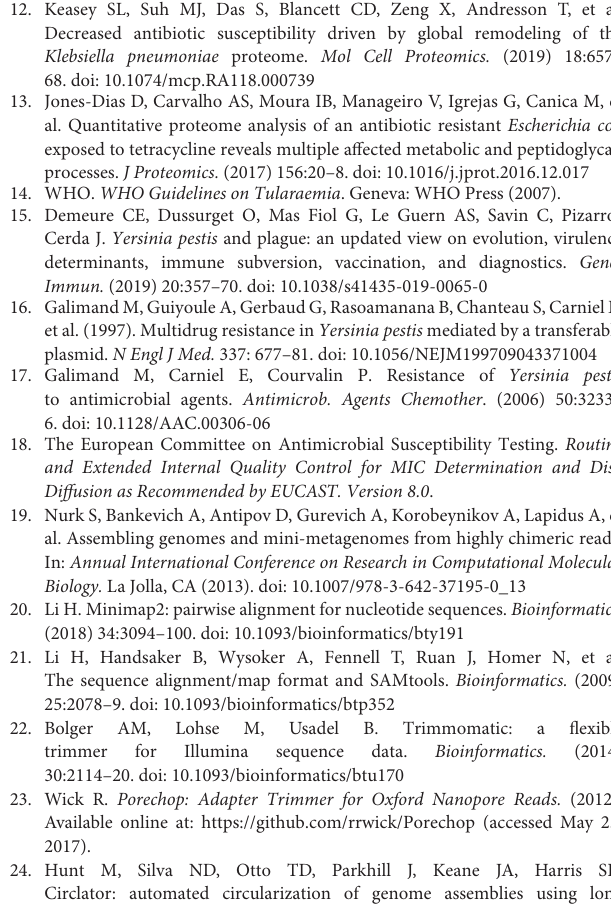
Supplementary Figure 1 | Growth of Y. pestis strains in the presence and absence of antibiotics. Growth was assessed by optical density measurements during two growth phase windows (log phase between 9 and 12h post-inoculation and stationary phase growth at 24h post inoculation) for Y. pestis Yp4003 (AMR) and Yp4181 (AMS). Yp4003 was grown in the presence and absence of streptomycin (64 µ g/ml). Supplementary Figure 2 | Growth of F. tularensis subsp . tularensis (Type A) and subsp. holarctica ( Type B) AMR/AMS strains in Chamberlain’s media at 37 ◦ C. Growth was assessed by optical density measurements over 40h. The two AMR strains (FSC016 Type A and FSC232 Type B), were grown both in the presence and absence of either streptomycin (64 µ g/ml; strain FSC016) or rifampicin (5 µ g/ml; strain FSC232). The growth rate of the Type A strains FSC013 AMS and FSC016 AMR were relatively higher compared to the Type B strains FSC201 AMS and FSC232 AMR. Plotted values represent means and standard deviation from measurement of four replicates in three experimental runs ( n =